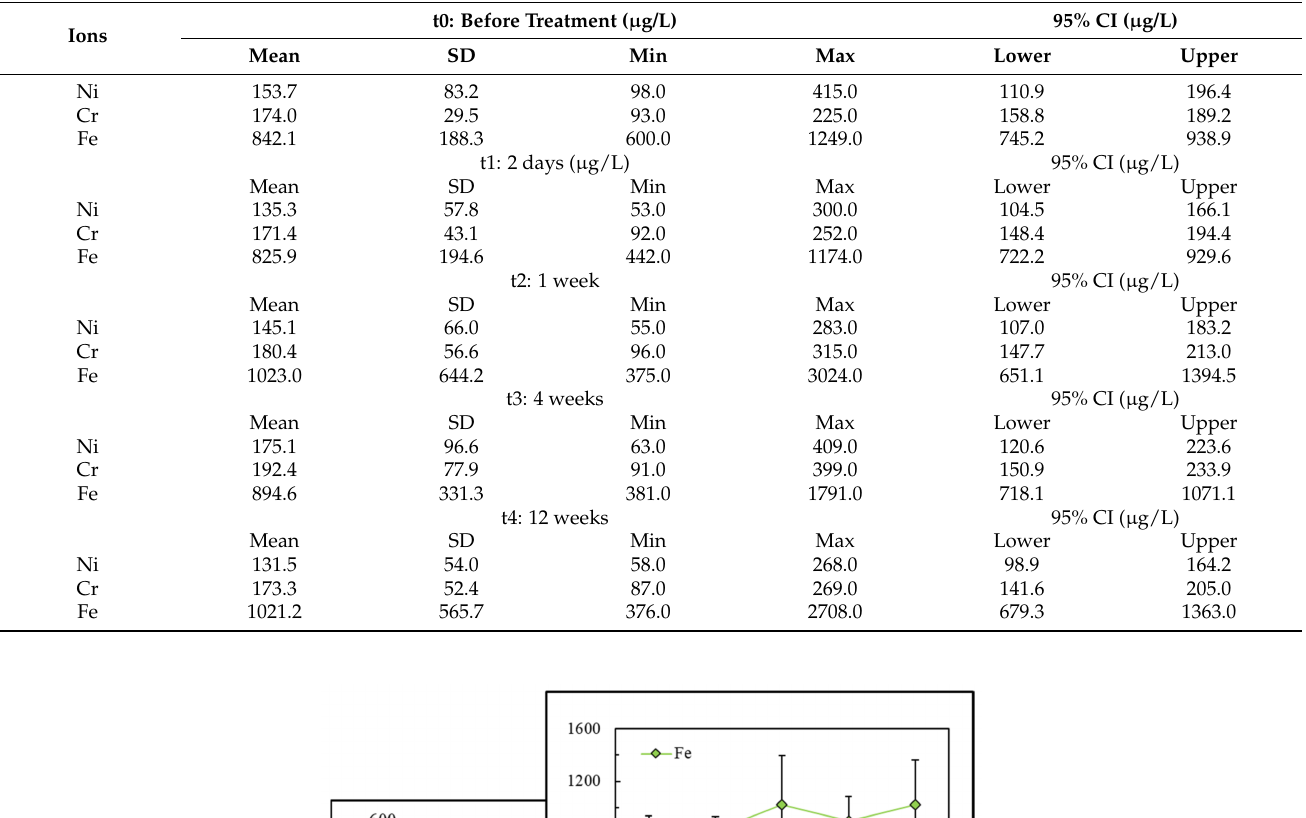
Table 4. Descriptive statistics for the salivary metallic ion content ( µ g/L) at the time intervals. SD: Standard Deviation; CI: Confidence Interval.